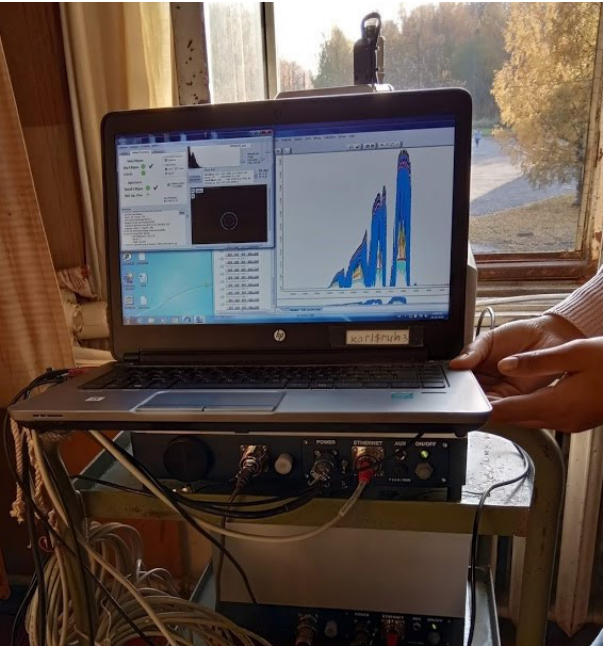
Figure 4. Instrument set-up at Peterhof. A huge window allowed for measurements from ∼ 10:00 to ∼ 15:30LT (local time) every